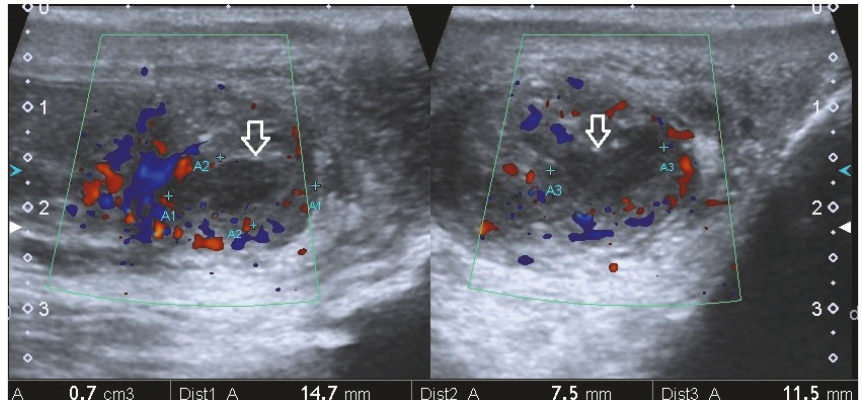
Figure 2: US Testicular Doppler. Hypoechoic collection of 0.7 cm 3 with debris in its interior (arrow) located in the tail of the left epididymis associated with an increase in volume and vascularization of the epididymis (blue and red signal).